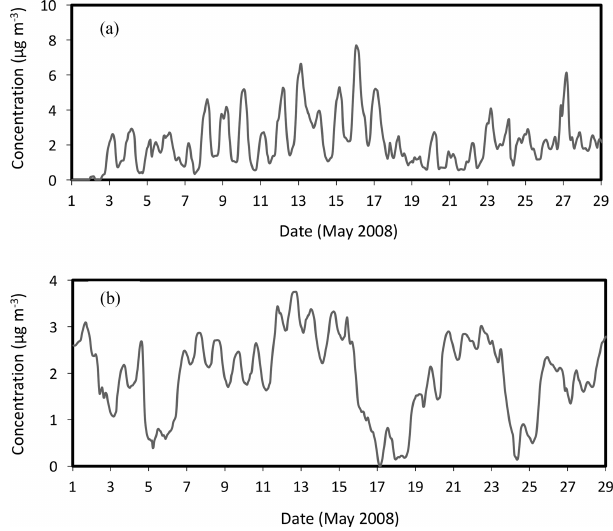
Figure 2. PMCAMx-SR factor time series of the (a) SOA and (b) LRT factors in Melpitz during May